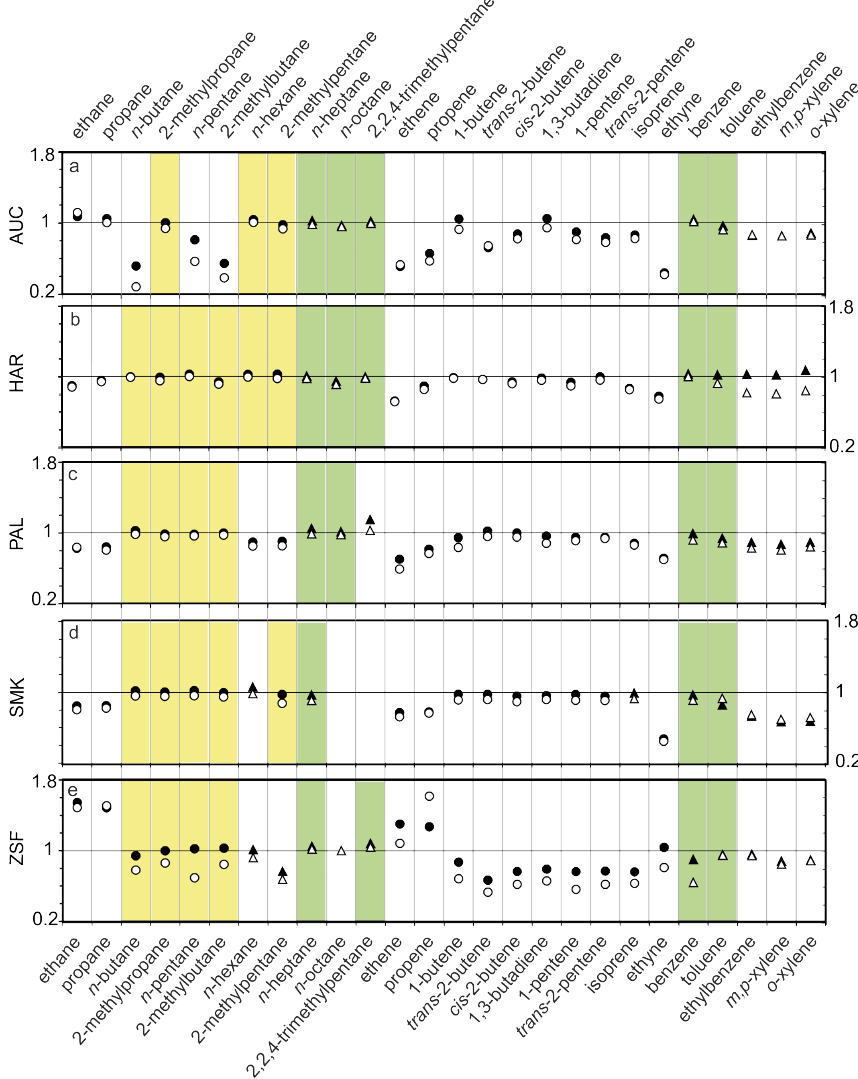
Figure 4. FID C responses as an indicator of NMHC measuring system artefacts. Circles (O) indicate column one, triangles ( (cid:49) ) column two. Filled symbols indicate the C responses in the calibration standard, open symbols the C responses in NMHC_N 2 . The C responses for column one were normalised by the average C response of the available C 4 –C 6 alkanes (highlighted in yellow), column two by the average C response of the available C 7 –C 8 alkanes, benzene, and toluene (highlighted in green). If an individual C response deviated by more than 10% from the average C response, the value was not considered in the normalisation